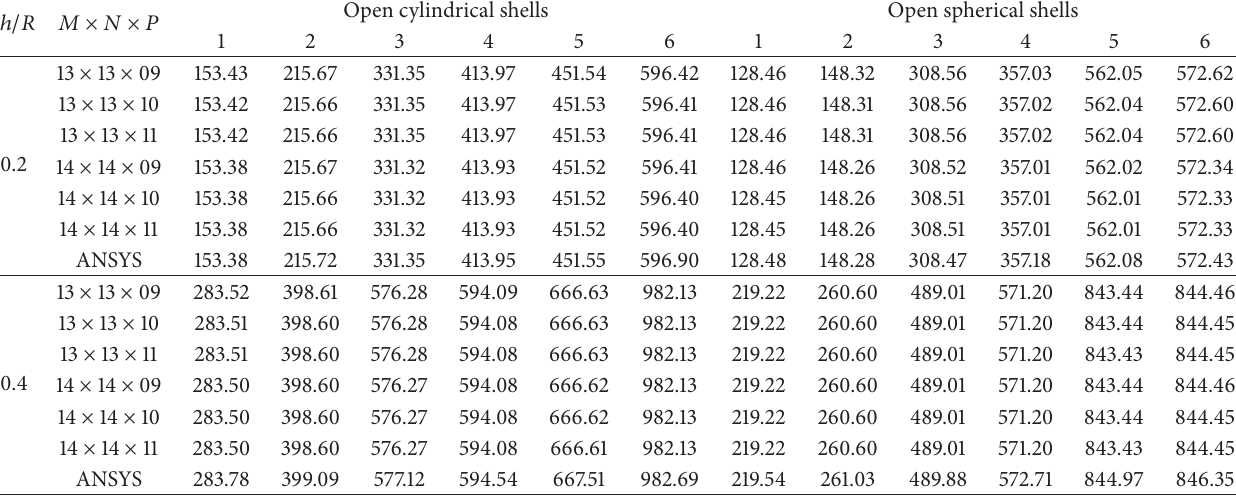
Table 1: Convergence of the first six nature frequencies (Hz) of open cylindrical and spherical shells with FFFF boundary conditions. ℎ/𝑅 𝑀 × 𝑁 ×